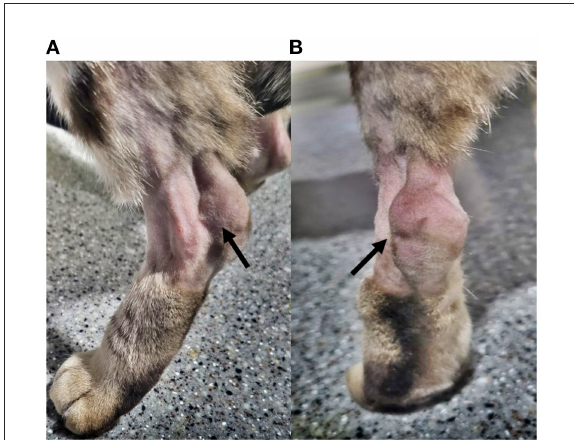
FIGURE1 Gross appearance. Gross appearance of the calcaneal region at the initial evaluation. Hair around the region has been clipped for assessment. (A) Lateral view of the left calcaneal region (arrow). (B) Caudocranial view of the left calcaneal region. Remarkable swelling is confirmed around the calcaneal tuberosity (arrow).